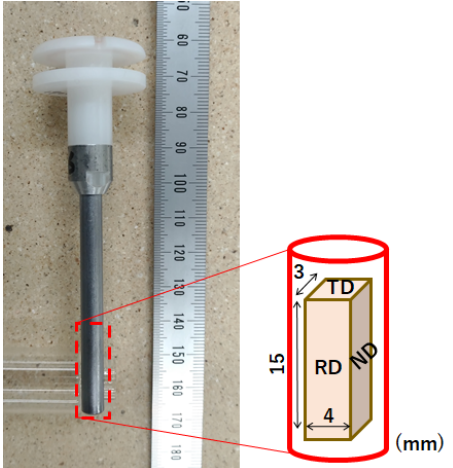
Figure 1. Vanadium cell used for the neutron diffraction experiments at iMATERIA, Japan Proton Accelerator Research Complex (J-PARC) Materials and Life Science Experimental Facility (MLF), Ibaraki, Japan. ND: sample normal; RD: rolling direction; TD: transverse direction.